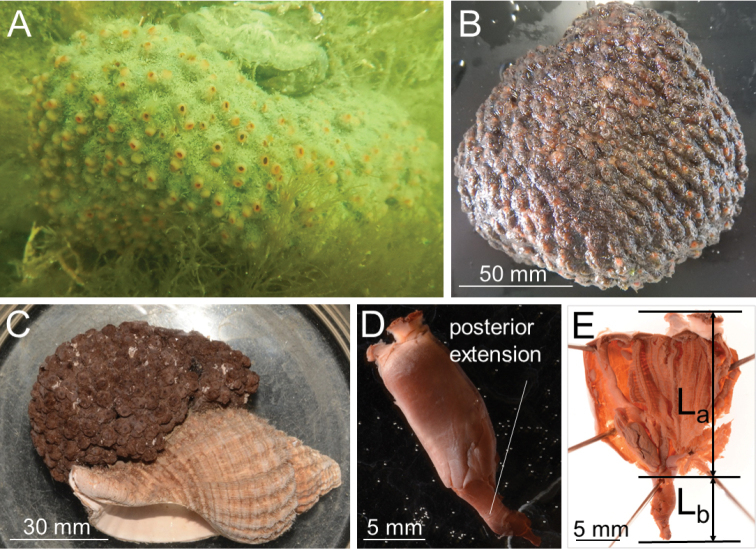
Syncarpacomposita (Tokioka, 1951). A, B, D, EICHUM 5817 CSMBL 104 (syntype). A Live colony B intact colony C preserved colony D intact zooid E zooid showing length from top of siphon to end of stomach (La) and from end of stomach to posterior end of zooid (Lb).